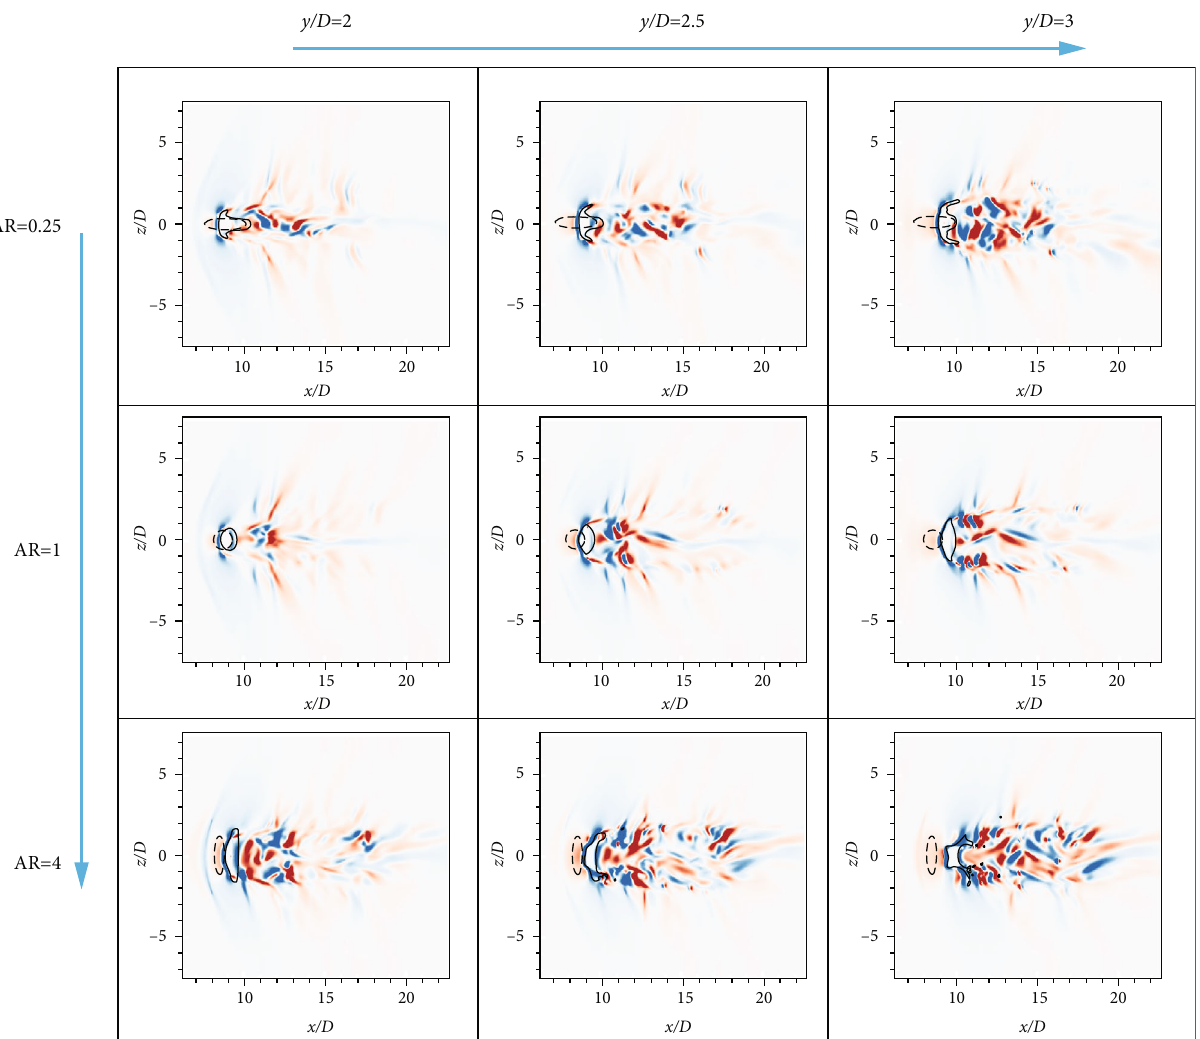
Figure 13: Vorticity distributions at y / D = 2 , 2.5, and 3 for Case 1, Case 3, and Case